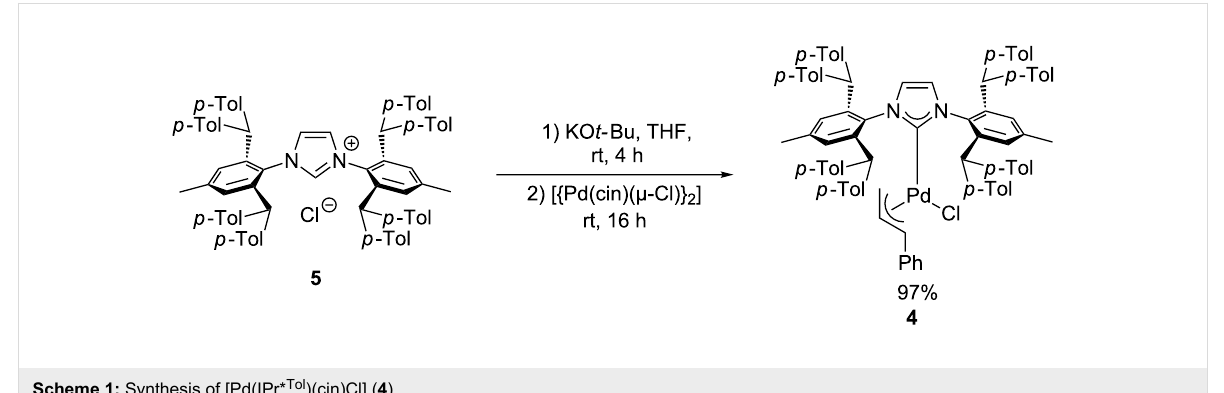
Scheme 1: Synthesis of [Pd(IPr* Tol )(cin)Cl] ( 4